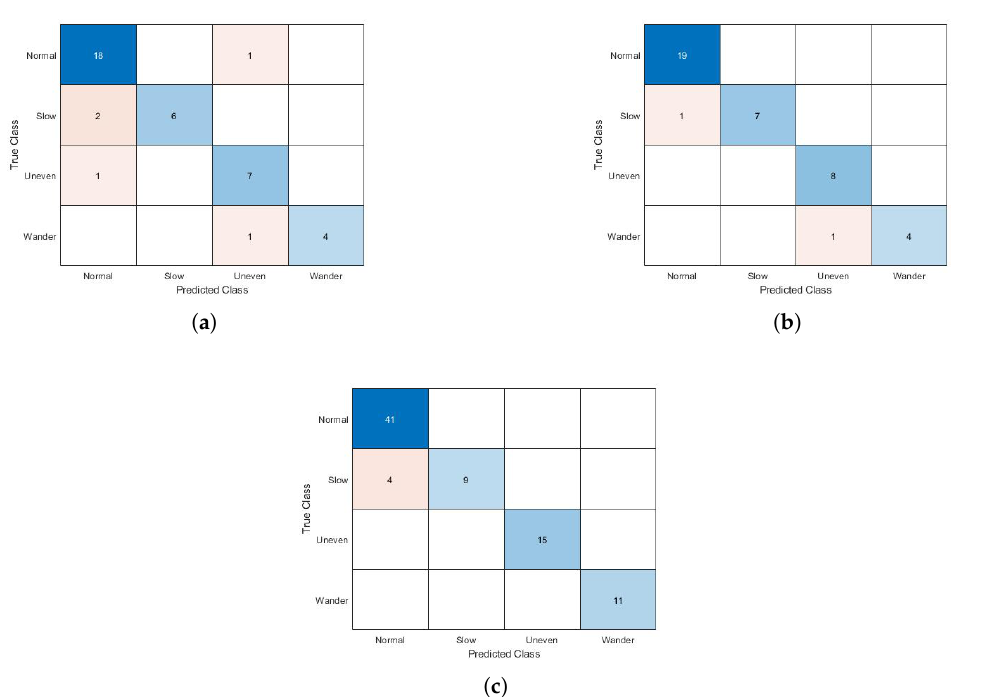
Figure 12. Confusion matrix for four different walking patterns. ( a ) Confusion matrix for micro- Doppler signatures; ( b ) confusion matrix for interferometric signatures; ( c ) confusion matrix for dual micro-motion